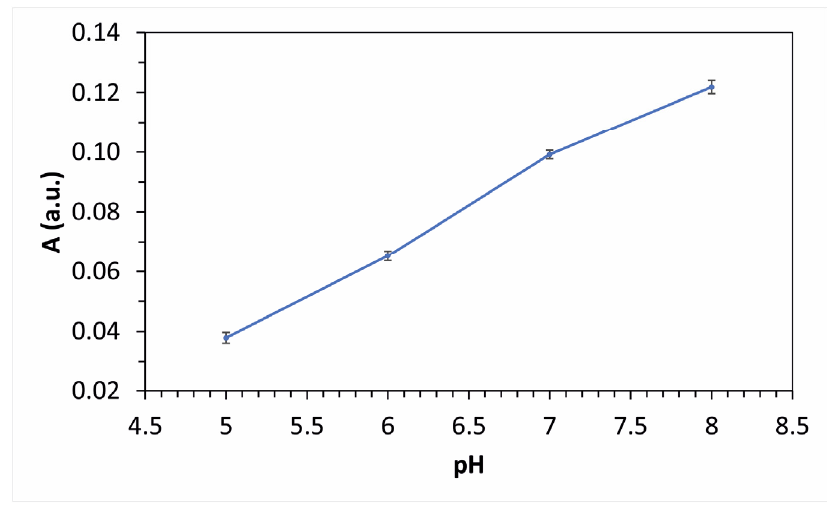
Figure 2. Calibration curve for sensor number 1 obtained on 22 November 2019. Table 1. Sensor position during the evaluation carried out in February 2019.